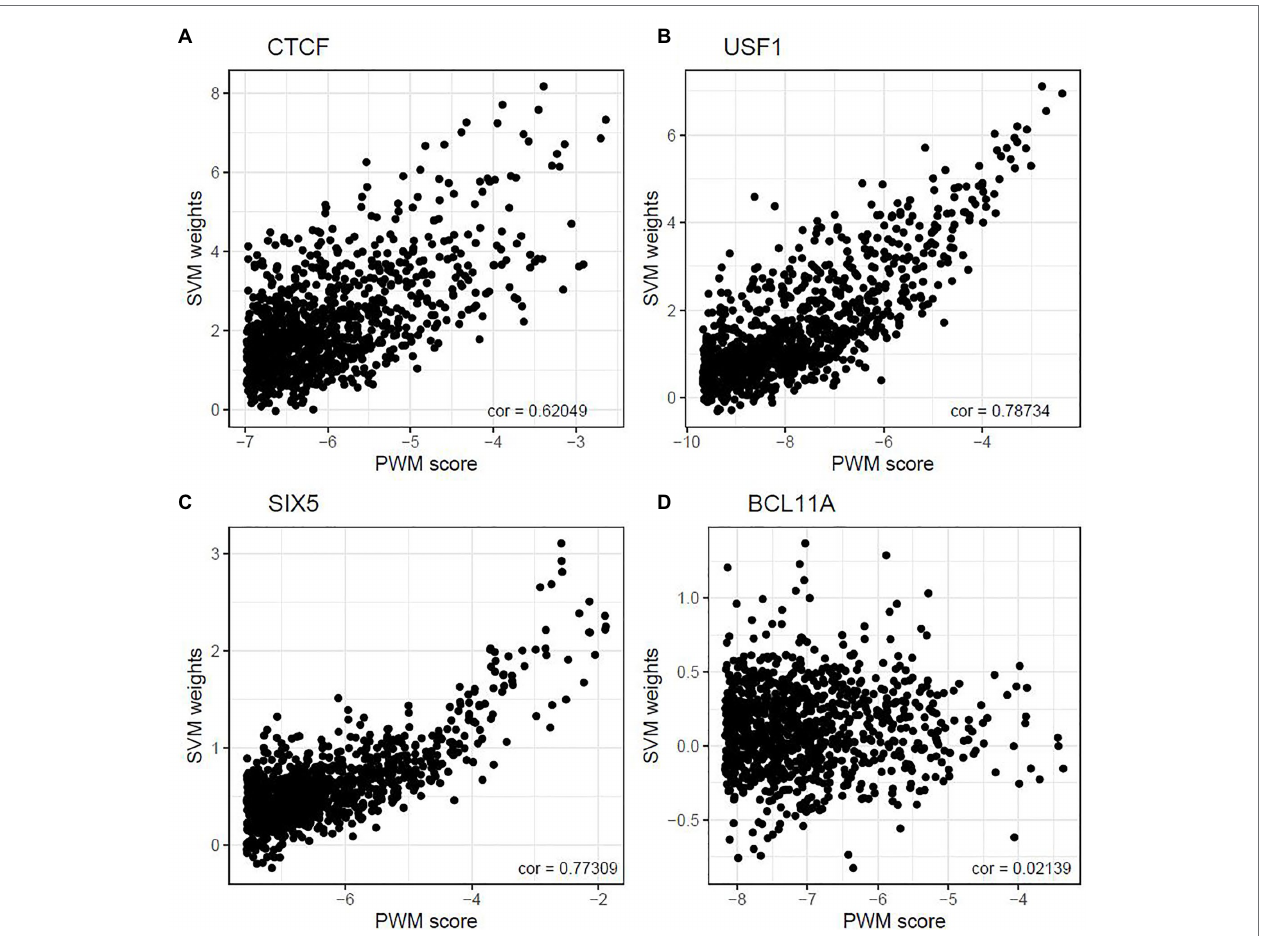
FIGURE 1 | Correlation between top-ranked 10-mer’s PWM score and their weight. The correlations between 10-mer PWM scores and SVM weights were 0.620, 0.787, 0.773, and 0.021 for CTCF (A) , USF1 (B) , SIX5 (C) , and BCL11A (D) in GM12878,